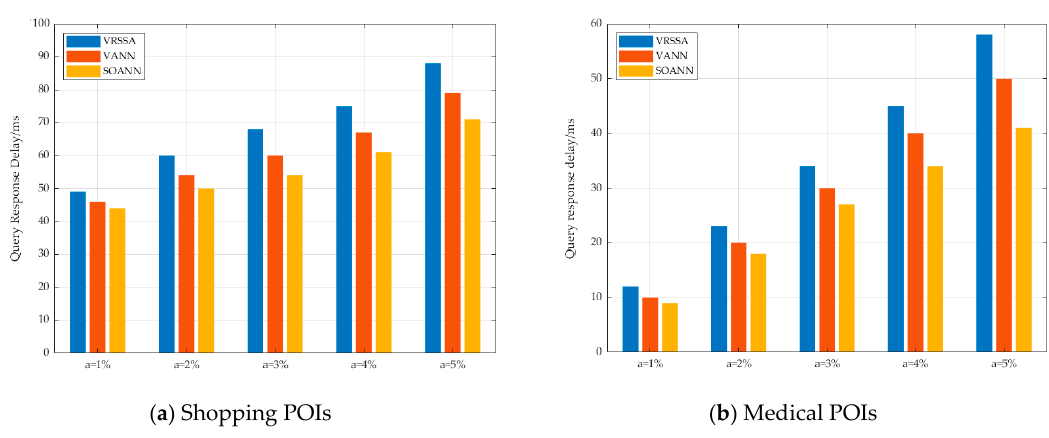
Figure 18. The effect of user distribution on query performance. Figure 18. The e ff ect of user distribution on query